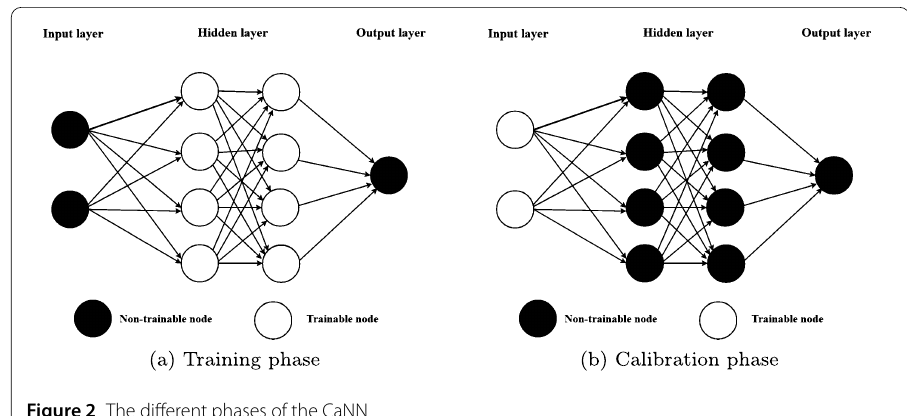
Figure 2 The different phases of the